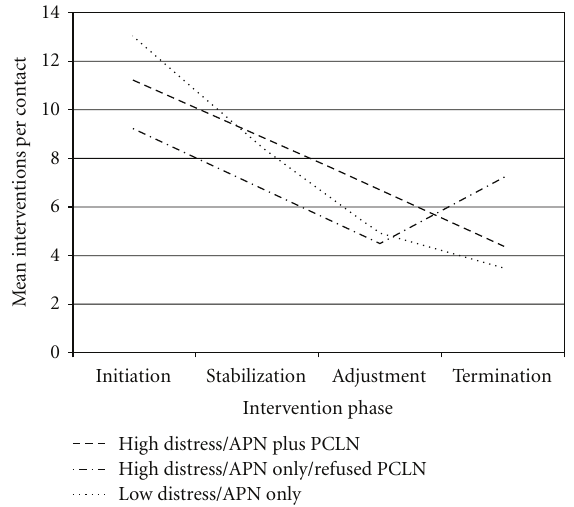
Figure 5: Mean interventionsper contact per intervention phase for each subsample: physiological problems.